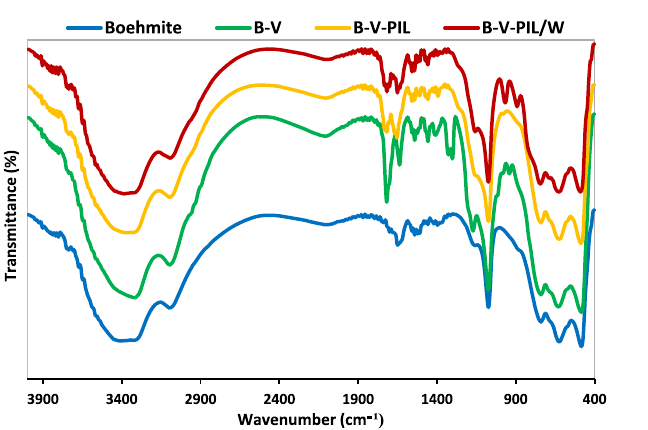
Figure 5. FTIR spectra of boehmite, B-V, B-V-PIL and B-V-PIL/W.